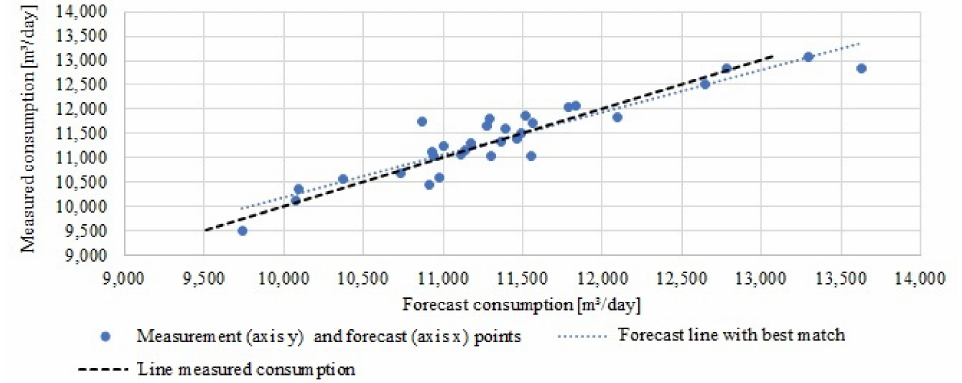
Figure 13. Forecast value and actual natural gas consumption fit on individual days.